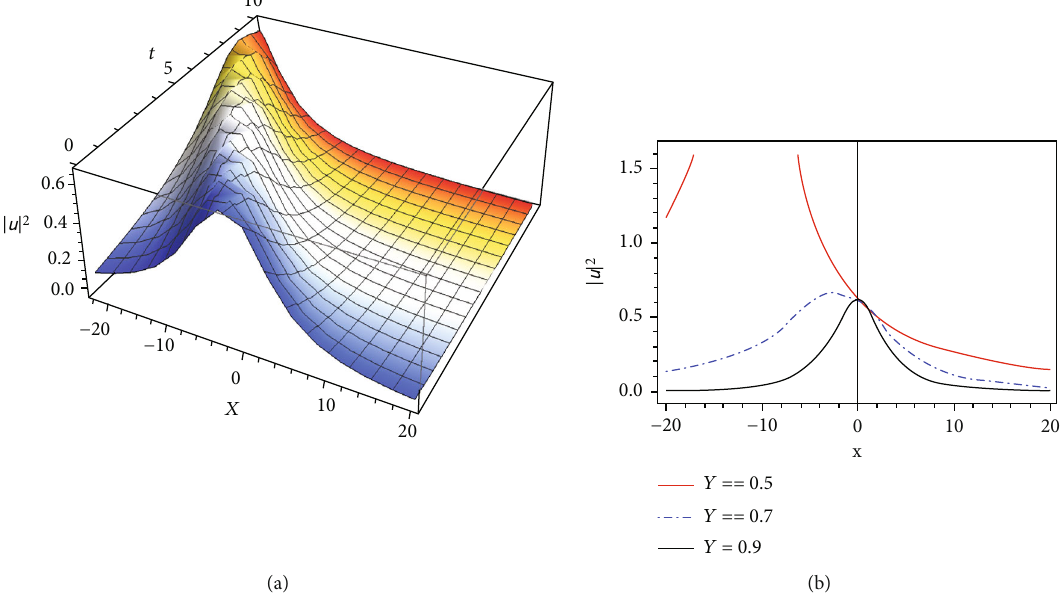
= 1 , S = − 1 , T = 2 , V = 1 , and γ = 0 : 5,0 : 7,0 : 9 for the solution obtained in Equation (29). (a) The 3D-plot Figure 2: We suggest κ = 2 , l = 1 , β 1 of j u j 2 with γ = 0 : 7 . (b) The 2D-plot of j u j 2 with distinct values of γ .